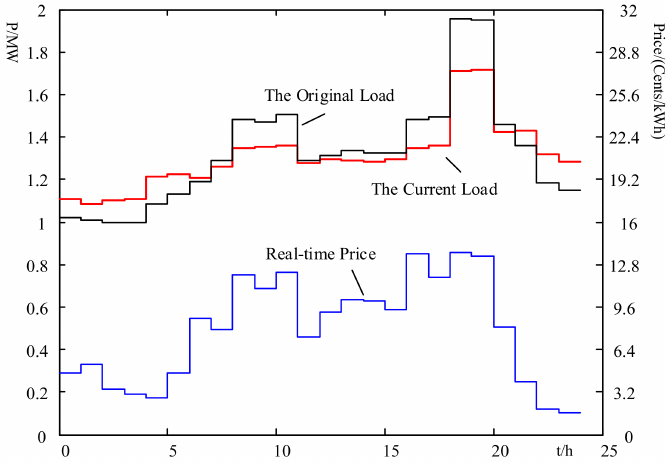
Figure 5. Day-ahead real-time price and load changes.